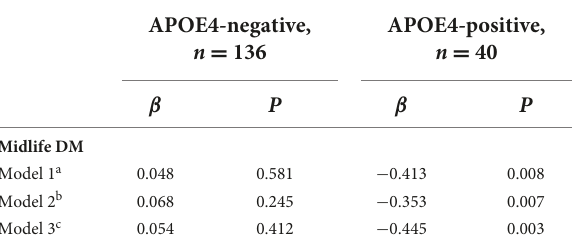
TABLE 3 The results of the multiple linear regression analyses for the associations between midlife DM and the TS by the APOE4-positivity